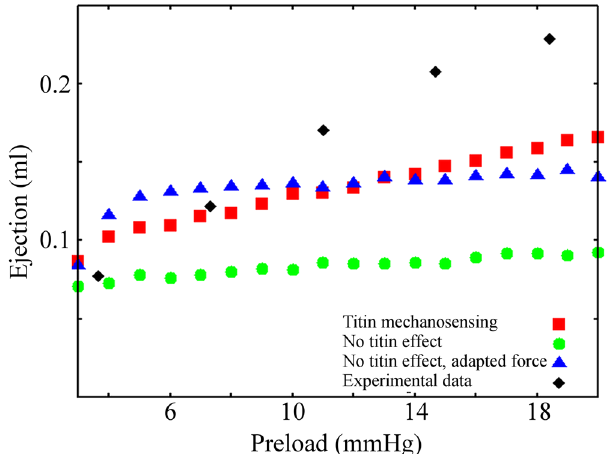
Figure 5. Left ventricle FE model simulations. Ejection predicted by the rotationally symmetric FE model of the rat left ventricle, against increasing preloads with the double-cycle model (red squares), compared with the experimental data (black diamonds). The ejection increases at higher preloads, showing that the model can reproduce, at least qualitatively, the Frank-Starling law. The passive tension effects of titin on the mechanosensing mechanism are eliminated from the model in two ways (blue triangles and green dots). Neither predicts an increased ejection, except for small preloads, which lead to decreased overlap of the two